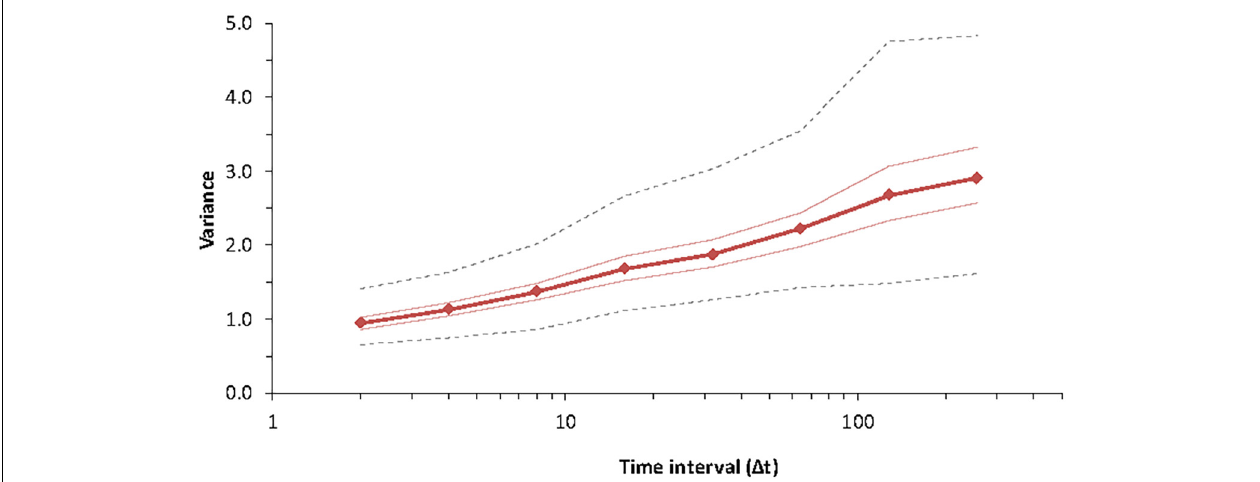
FIGURE 4 | Pattern of variance growth in the model with observation time for Special Case B for species #3 (chosen at random) of the community, with parameters K = 7 and B = 1.9, J = 4 × 10 4 for 256 time steps. The lines indicate the median, minimum, maximum and the two hinges (25th and 75th percentiles) for 1,000 replicates. The dynamics proceed as for Equation (10) and do not include extinction or